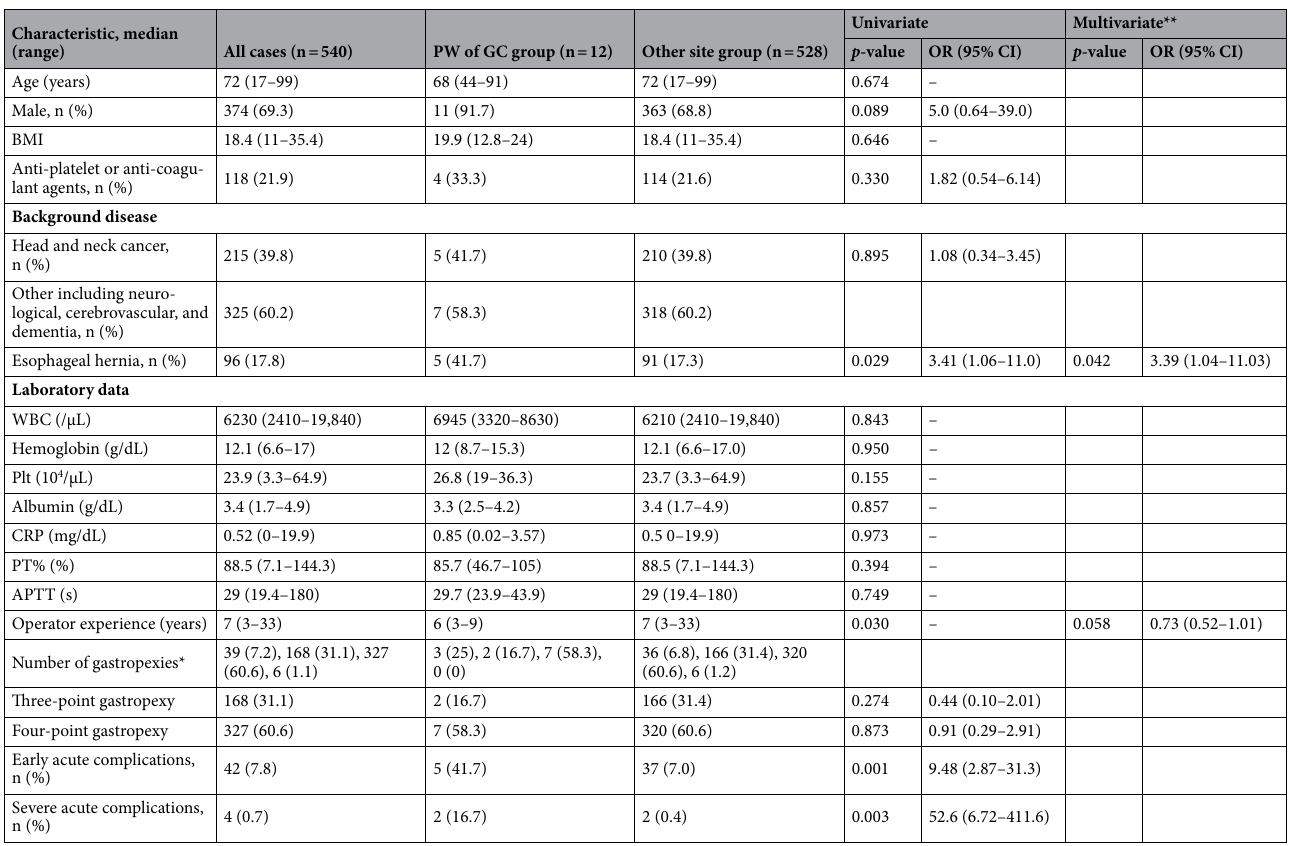
Table 1. Patient background and univariate analysis of PEG site (n = 540). Early acute complications were defined as bleeding and perforation. Severe acute complications were defined as those requiring surgical intervention. The significance of an association was evaluated using the chi-square test. Fisher’s exact probability test was used for groups with fewer than five samples. The Mann–Whitney U-test was employed to analyze continuous variables. APTT activated partial thromboplastin time, BMI body mass index, CRP C-reactive protein, GC greater curvature, OR odds ratio, PEG percutaneous endoscopic gastrostomy, Plt platelet count, PT% prothrombin%, PW posterior wall, WBC white blood cell count. *Two-point fixation, three-point fixation, four-point fixation, and unknown. **The two significant univariate analysis factors of esophageal hernia and operator experience were included in multivariate analysis.